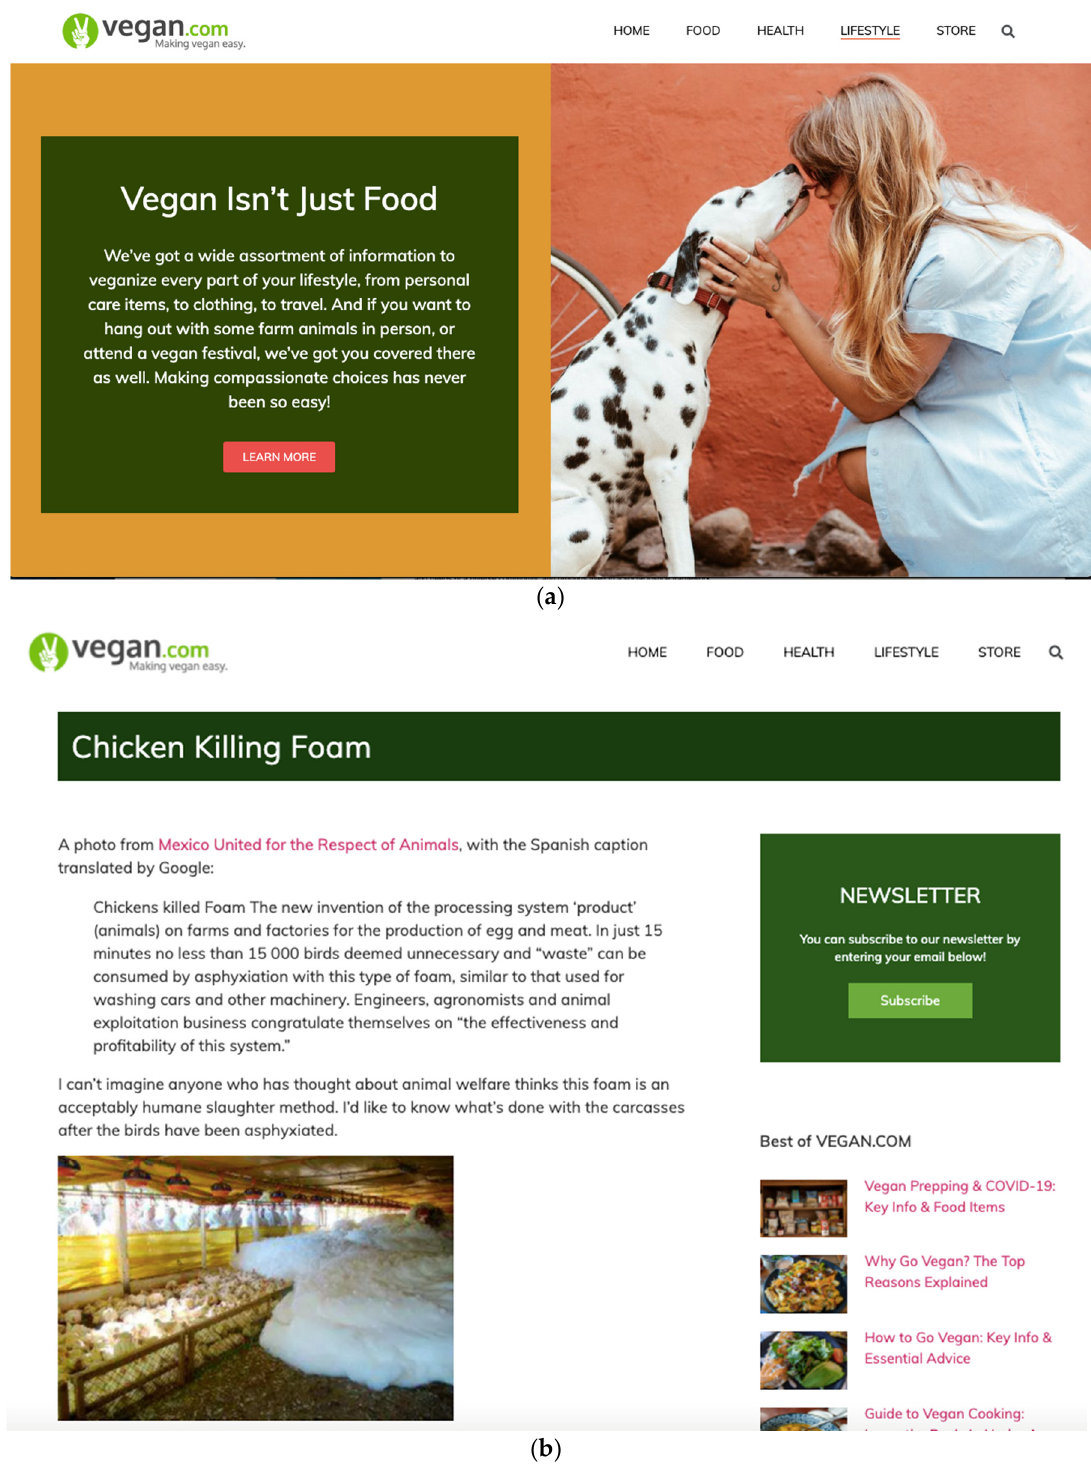
Figure 9. ( a ). Vegan website, Lifestyle page (https://www.vegan.com/lifestyle/, accessed on 2 November 2021). ( b ). Vegan website, Chicken Killing Foam page (https://www.vegan.com/chicken-killing-foam/, accessed on 2 November 2021).